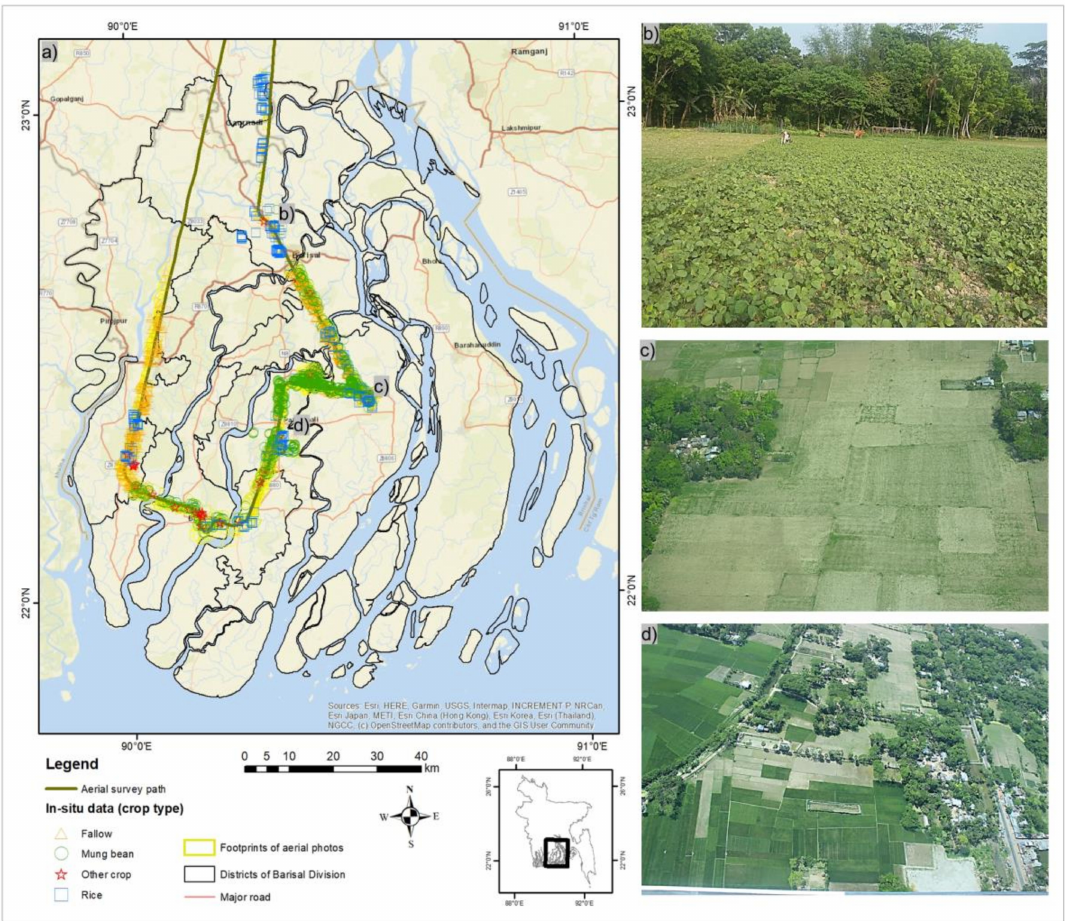
Figure 4. ( a ) The flight path of the S2-AEC sea plane used for crop field surveillance at 150–300 m height on 25 March 2019. A mung bean field is shown in ( b ). Panels ( c ), mostly mung bean, and ( d ), with lush green rice fields, are photos taken from the aircraft. Locations are indicated on ( a